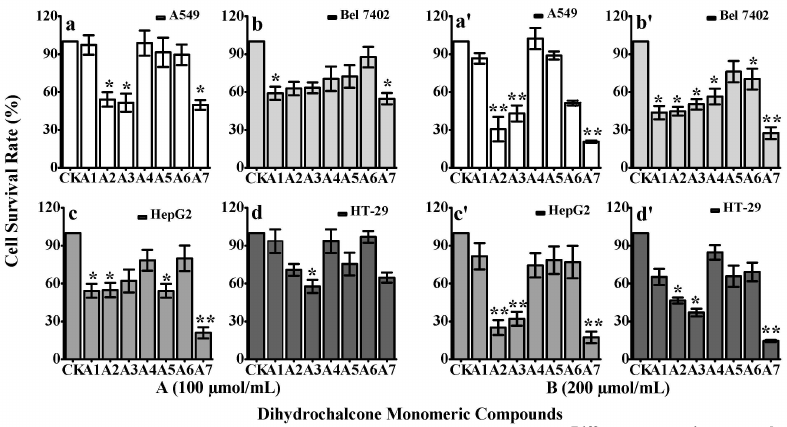
Figure 3. Anti ‐ tumor therapeutic effects of the monomeric dihydrochalcone compounds from Malus “Radiant” crabapples. Human lung adenocarcinoma cell line A549, human hepatoma cell line Bel 7402, human cancer colorectal adenoma cell line HepG2 and colon cancer cell line HT ‐ 29 were treated with the indicated concentrations of various extracted fractions of Malus “Radiant” crabapples. The cell viability was then determined by an MTT assay, and the mean ± SD of six separate experiments was shown (( A ) the concentration of monomeric compounds was 100 μ mol/mL; ( B ) the concentration of monomeric compounds was 200 μ mol/mL). The data shown are the mean ± SD. ** and * indicate significance at p < 0.01 and p < 0.05 by t ‐ test, respectively.